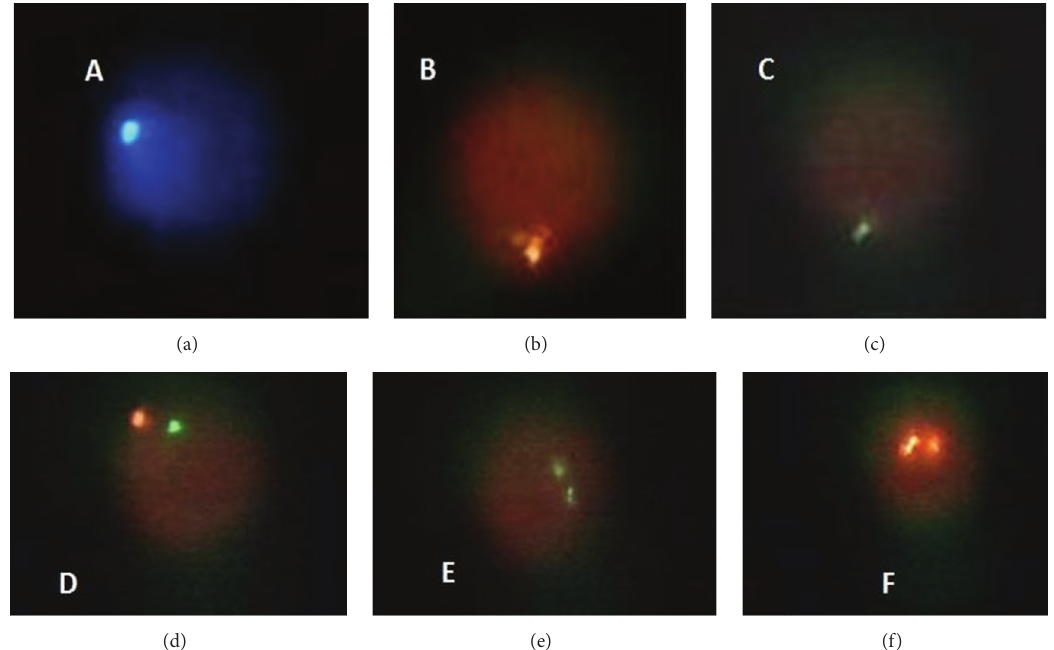
Figure 2: Different images of the patient’s sperm FISH: (a) (18), (b) (Y), (c) (X) normal gametes, (d) (XY), (e) (XX), and (f) (YY) disomic gametes.